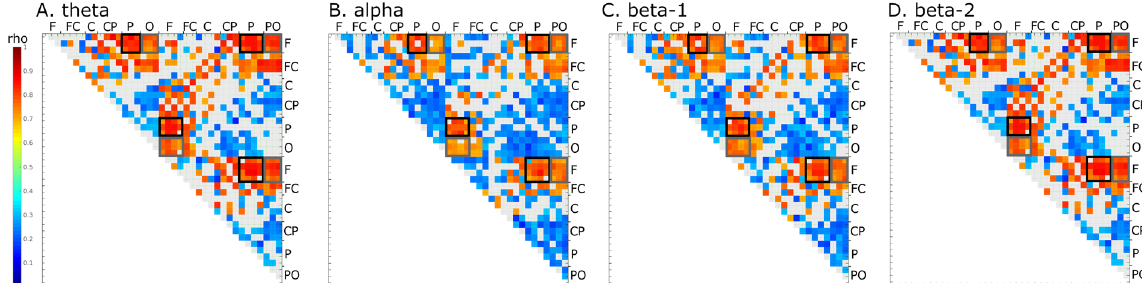
Figure 2. Significant correlations between gB2rest and phase-locking values (PLVs) of the resting-state measured before test session in: ( A ) theta, ( B ) alpha, ( C ) beta-1 and ( D ) beta-2 EEG bands. PLVs were calculated for averaged one second epoch. Shades of red and blue denote significant FDR-corrected correlation strength (color bar to the left) between the two signals recorded from electrodes indicated next to the box outlines. Light gray squares denote lack of significance. Gray outlines denote PLVs between frontal and occipital electrode sites; black outlines denote PLVs between frontal and parietal sites.